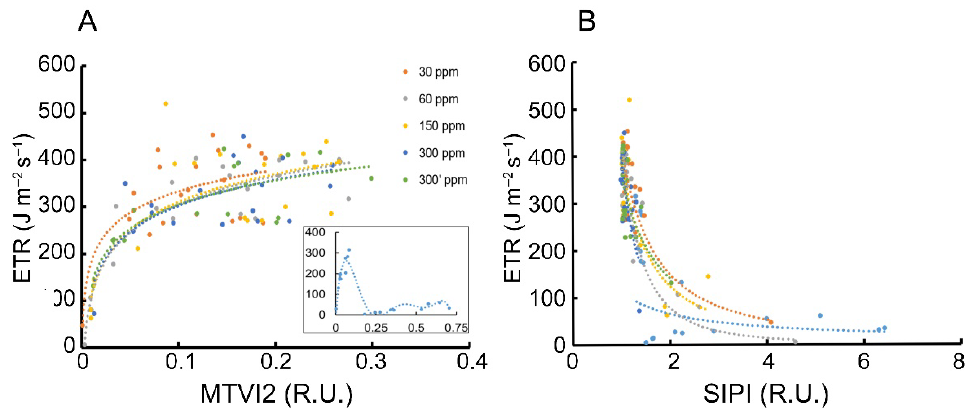
Figure 2. Covariance of the RS-ETRi index with vegetation indices related to canopy structure and stress. ( A ) Each point represents the covaried value between RS-ETRi and MTVI2. The six fertilization treatments were ‘no fertilizer’, 30, 60, 150, 300, 30 0′ ppm N, and are colored in light blue, orange, grey, yellow, blue, green, respectively, n = 5. The inset includes only the data of the no fertilization treatment. The dotted lines show the general trend and behavior of the data in each fertilization level; ( B ) similar to Panel A with a different vegetation index—SIPI. Colors representing the fertilization treatments are the same as in Panel ( A ).